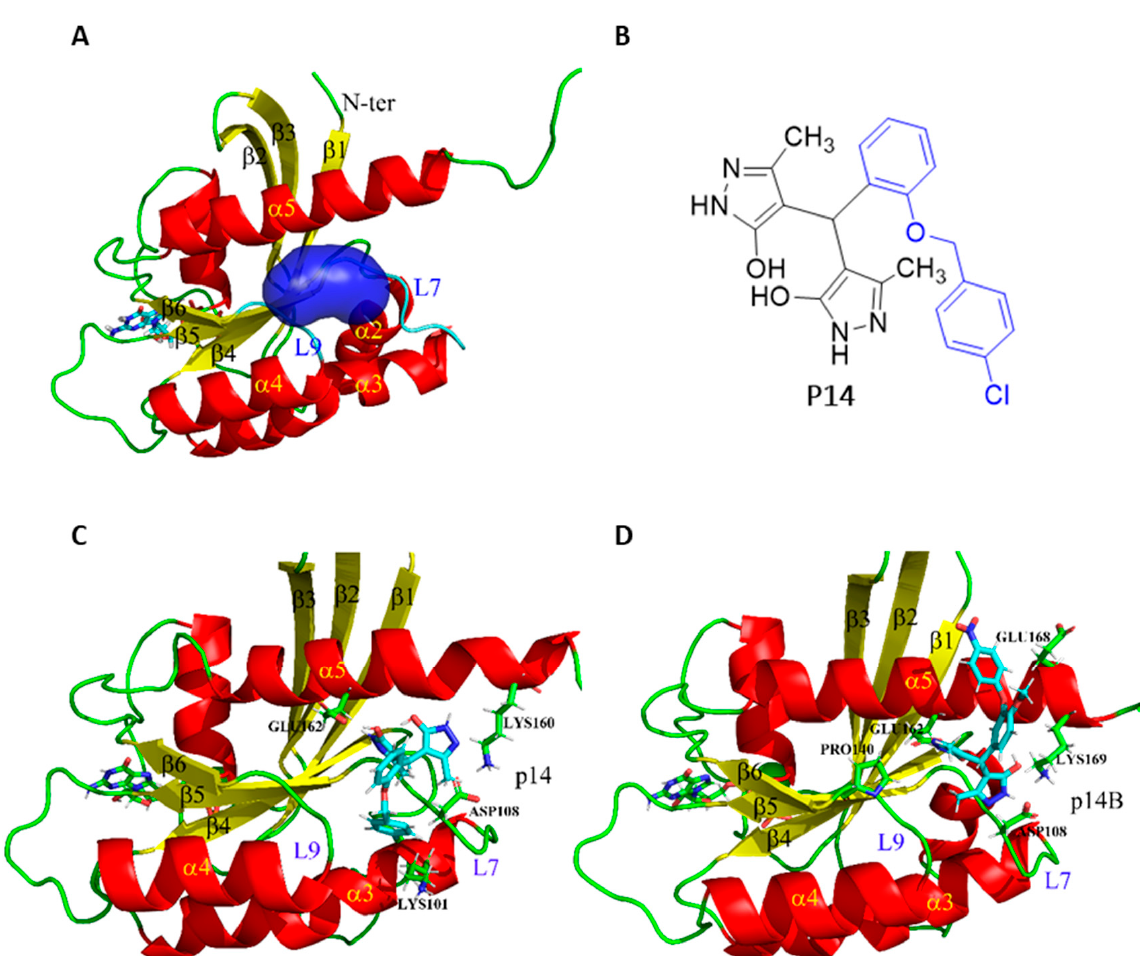
Figure 1. ( A ) KRAS binding site for calmodulin (CaM). Representation in blue surface of the binding site suggested both experimentally [37] and theoretically [36]. ( B ) Formula of the compound P14. ( C , D ) Spatial representation of the KRAS-P14 and KRAS-P14B complex at the end of 100ns of conventional molecular dynamics.